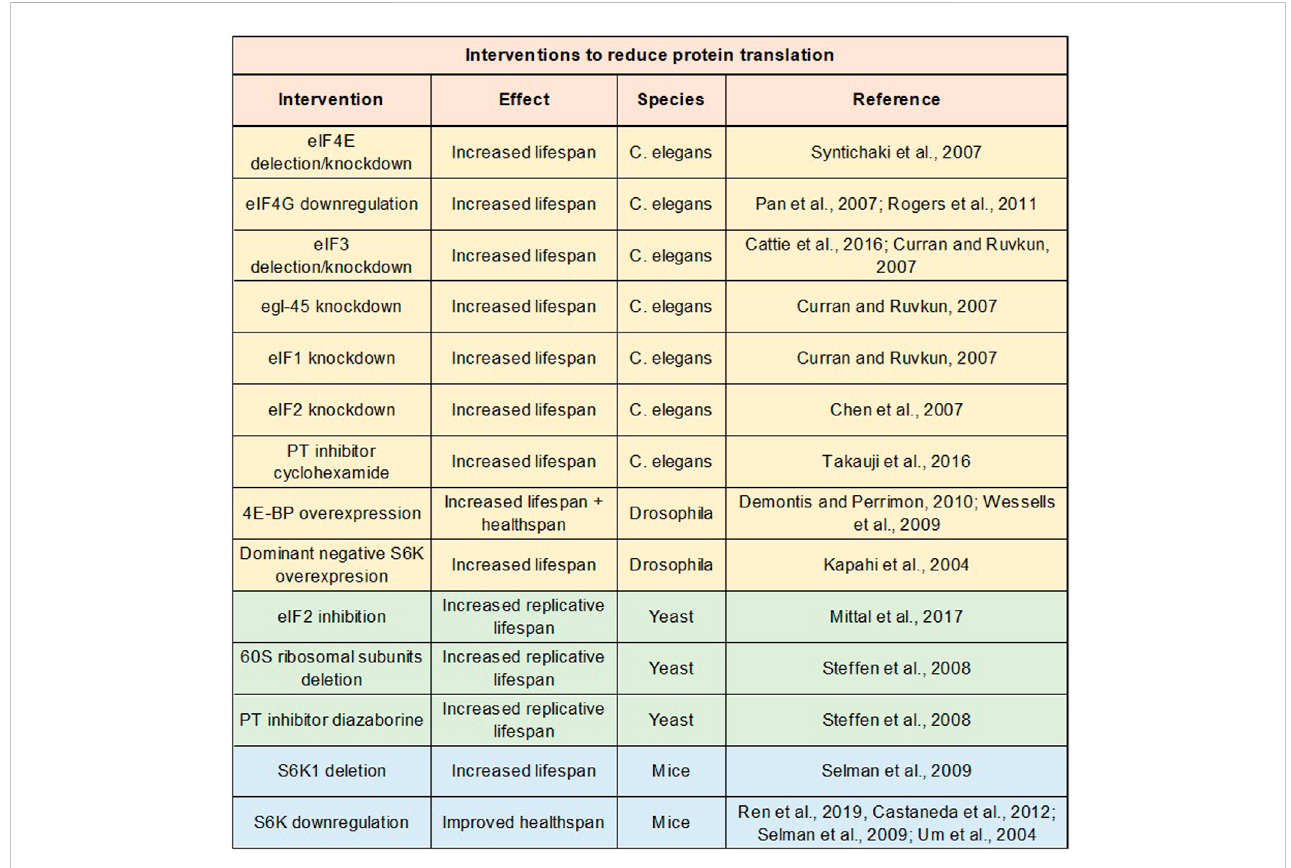
FIGURE 4 Impact of protein translation repression on lifespan and healthspan. Table of studies examining impact on lifespan or healthspan of genetic and drug interventions to repress protein translation.